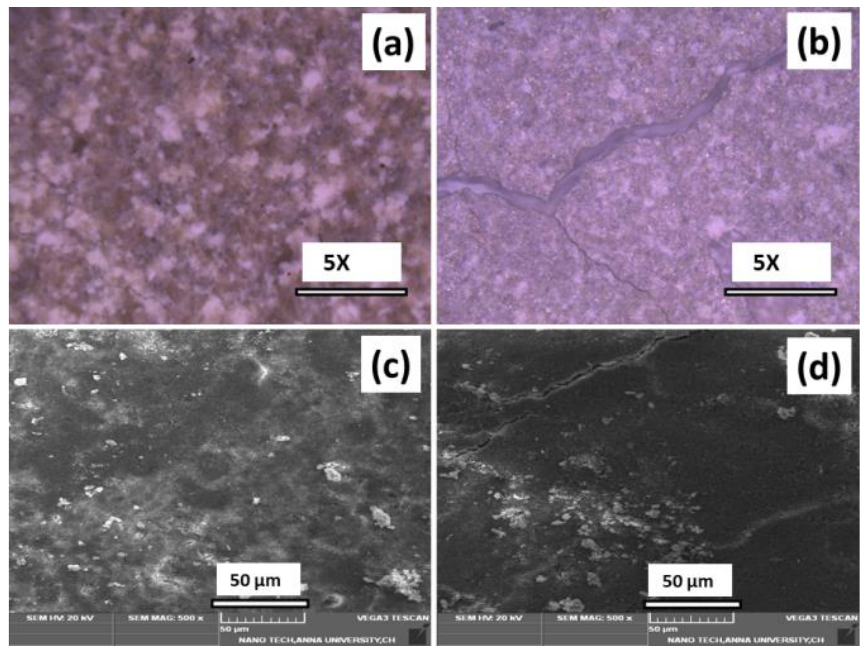
Figure 10. Bioactivity investigation recorded by the optical microscopic images for BCP ( a ) and Ag-BCP s (b) samples and the corresponding SEM images of BCP ( c ) and Ag-BCP ( d ). Optical microscopic and SEM images of BCP and Ag-BCP samples are employed to 396